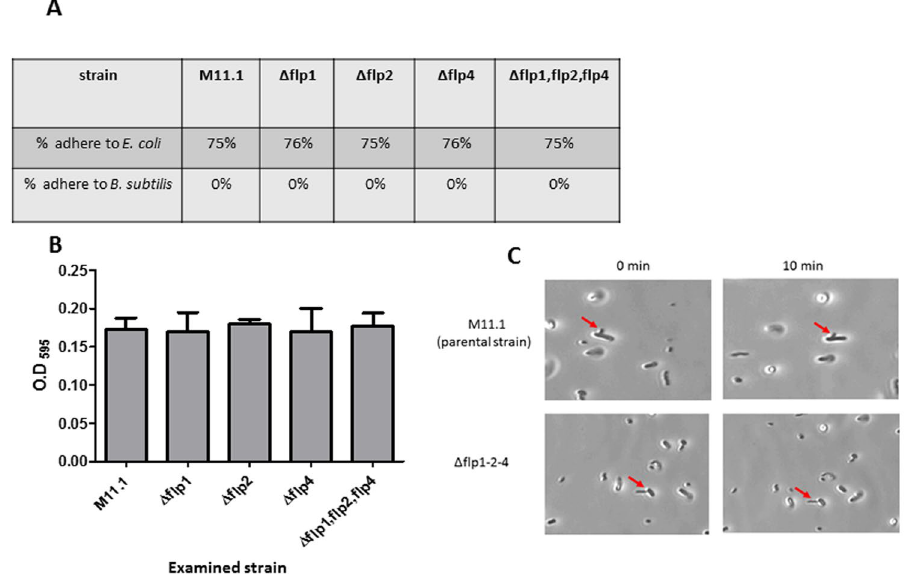
Figure 6. Adherence of flp knockouts to live prey and to abiotic surfaces. ( A ) HI M11.1 single and triple knockouts of flp1, flp2 and flp4 were examined for their ability to adhere to E. coli cells. No difference was observed between all the knockout strains and the HI M11.1 parental strain. B. subtilis served as a negative control for adhesion. ( B ) Examination for biofilm formation (adherence to abiotic surfaces), as in section A, no difference was observed between the strains. ( C ) Phase microscopy illustrating the adhesion assay. As in the parental HI M11.1 strain, the non-predatory mutant Δ flp 1-2-4 only attached to E. coli through the predatory pole. Similar results were obtained with the individual flp1 , flp2 and flp4 mutants ( > 100 events examined), in suspensions containing 10 6 or 10 7 cells.ml − 1 . In all mutants, the cells did not detach from E. coli during the examination time (10 min). Pictures were taken with a Digital Sight D5 camera (Nikon) and captured with a NIS-element software with no further